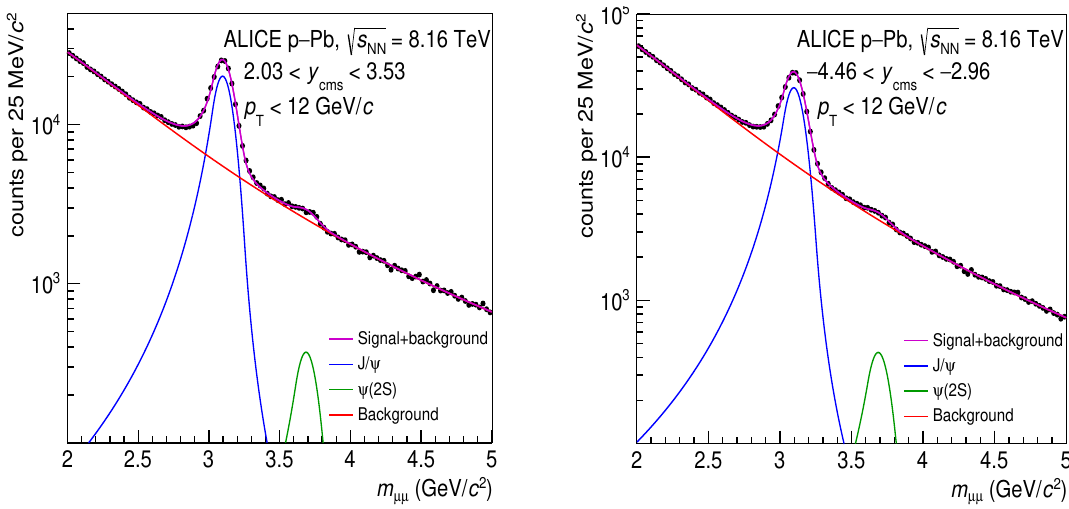
Figure 1 . Fit examples of the p T and y integrated mass spectrum for the forward (left) and backward (right) rapidity data samples. The contribution of the resonances and of the background are also shown separately. These (cid:12)ts are performed using the CB2 as signal function and the VWG background